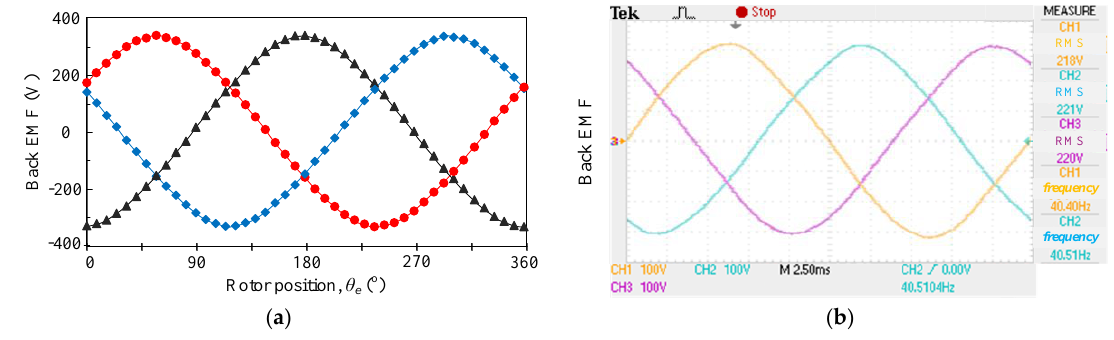
Figure 12. Back-EMF waveforms at the rated speed. ( a ) Finite element analysis (FEA) results; and ( b ) experimental results (100 V/div).